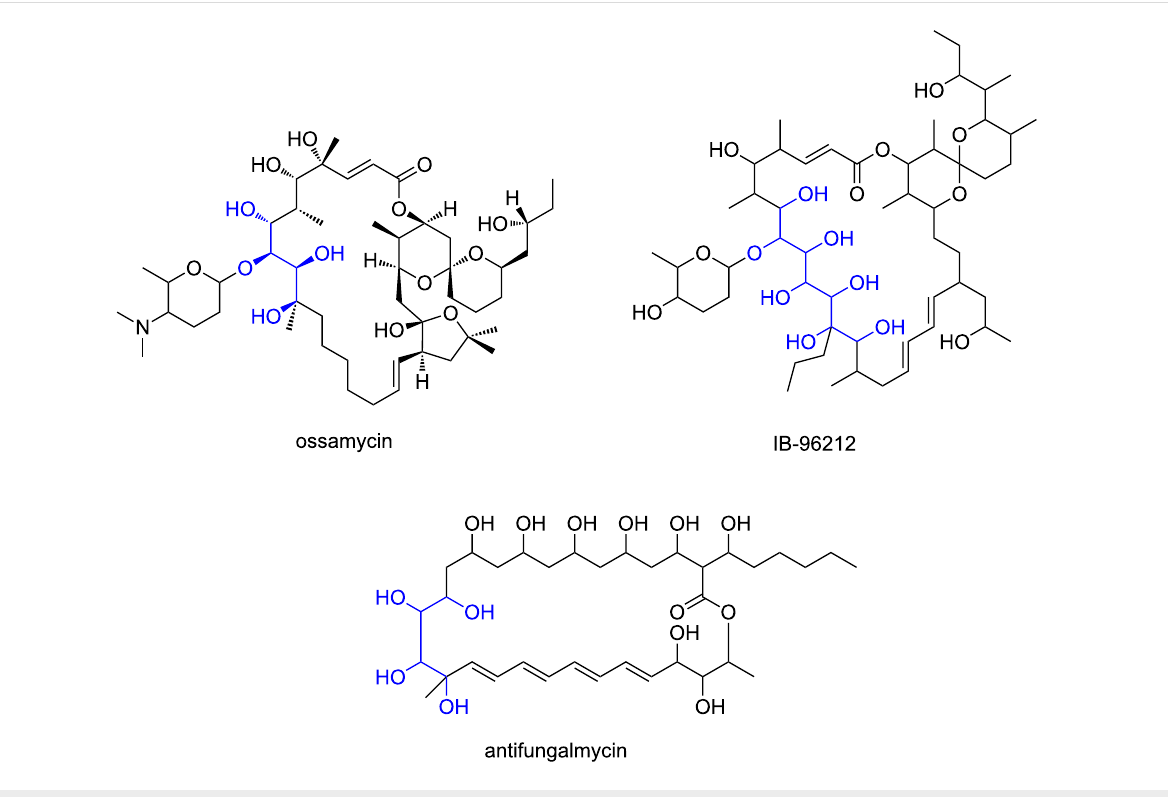
Figure 3: Actinomycete metabolites possessing a contiguous 1,2-diol